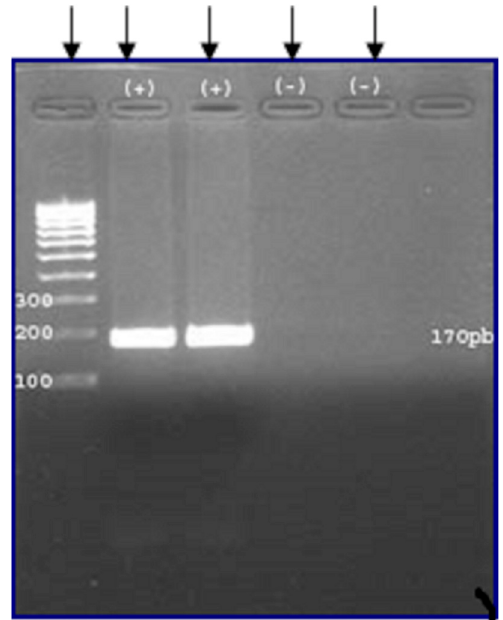
Figure 3. Agarose gel 2.5% electrophoresis of PCR products—from left to right: 100 bp DNA Ladder (first left column); PCR products of 170 pb E. ortleppi G5 (second and third columns); negative controls (fourth and fifth columns).